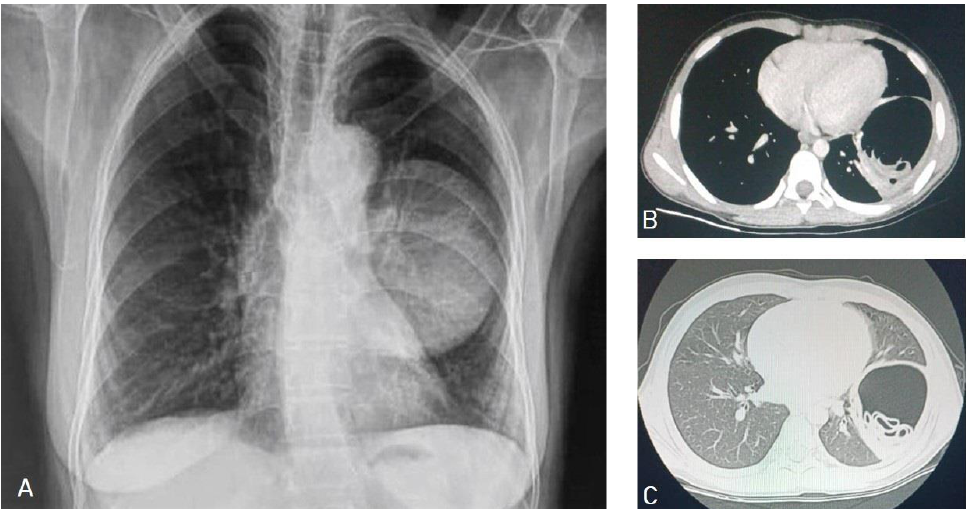
Figure 20. Chest X-ray of a 9-year-old male patient showing a well-defined oval shape with smooth margins and a large mass in the left lung ( A ). Selected axial CT images, mediastinal window ( B ), and lung window ( C ) show a well-circumscribed smooth margin intrapulmonary mass measuring 8.4 × 6.4 cm with fluid and gas contents with twisted-linear structures floating within the fluid contents of the cyst, forming a “water lily sign”, and representing hydatid cyst with detachment of the germinal membrane of the endocyst. The mass causes a mass effect in the form of compression of the lower lobe of the left